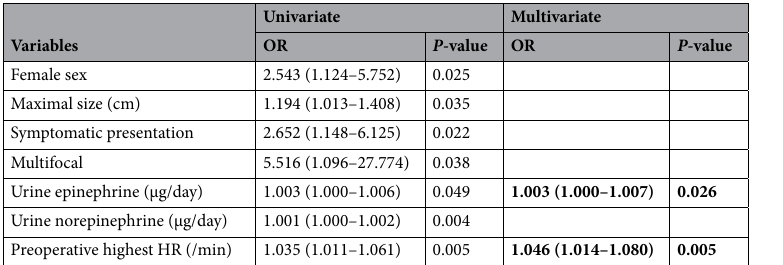
Table 6. Logistic regression analysis for predicting postoperative hypotension in PPGL patients. Variables with a P -value < 0.05 in univariate analysis were included in the multivariate logistic regression models, and forward stepwise selection based on the Wald test was performed. Data are shown as odds ratios (ORs) (95% confidence